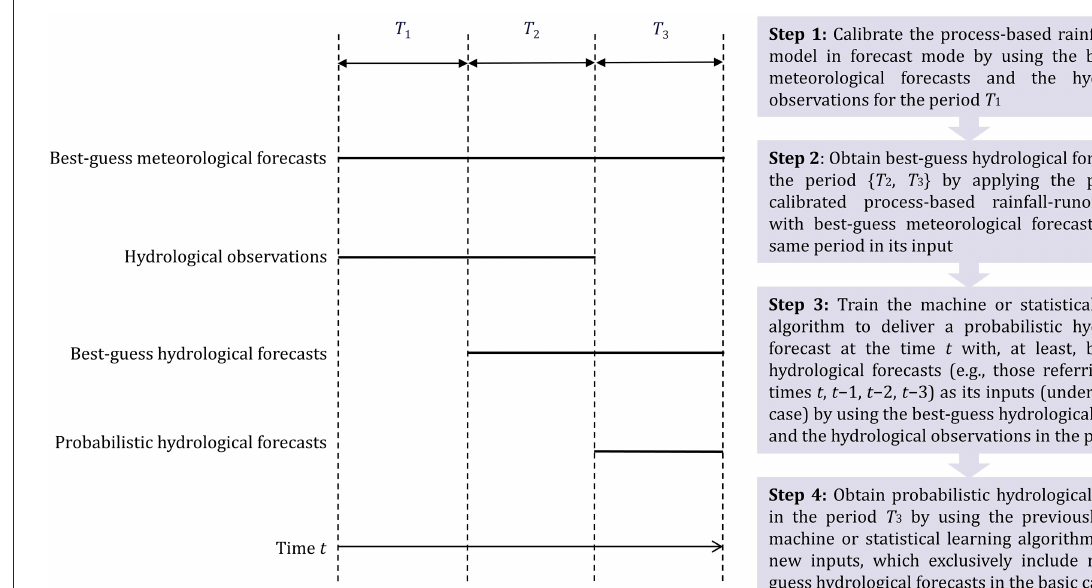
FIGURE2 Basic formulation of probabilistic hydrological post-processing for providing probabilistic hydrological forecasts in the period T 3 using a process-based rainfall-runoff model in forecast mode (i.e., with meteorological forecasts as its inputs; Klemeš, 1986) and a machine or statistical learning algorithm, along with best-guess meteorological forecasts and hydrological observations. The machine or statistical learning algorithm could originate from any of the families summarized in Section Quantile, expectile, distributional and other regression algorithms. For most of the quantile regression algorithms, steps 3 and 4 comprise in practice multiple trainings and runs, respectively, with each of them referring to a different quantile level, until all the quantile hydrological forecasts consisting the probabilistic hydrological forecast are issued. For example, for obtaining the probabilistic hydrological forecasts of Figure 1 through probabilistic hydrological post-processing using quantile regression neural networks (with the latter being the selected machine learning algorithm), steps 3 and 4 would comprise 5 trainings and 5 runs,